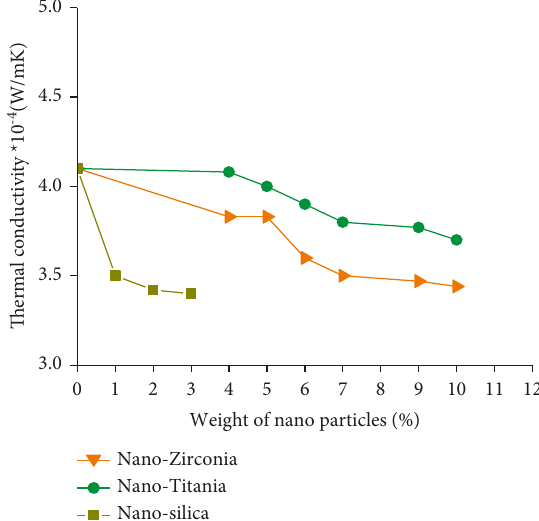
Figure 8: Thermal conductivity of nanofilled C-Ph laminate with nanofiller loading.